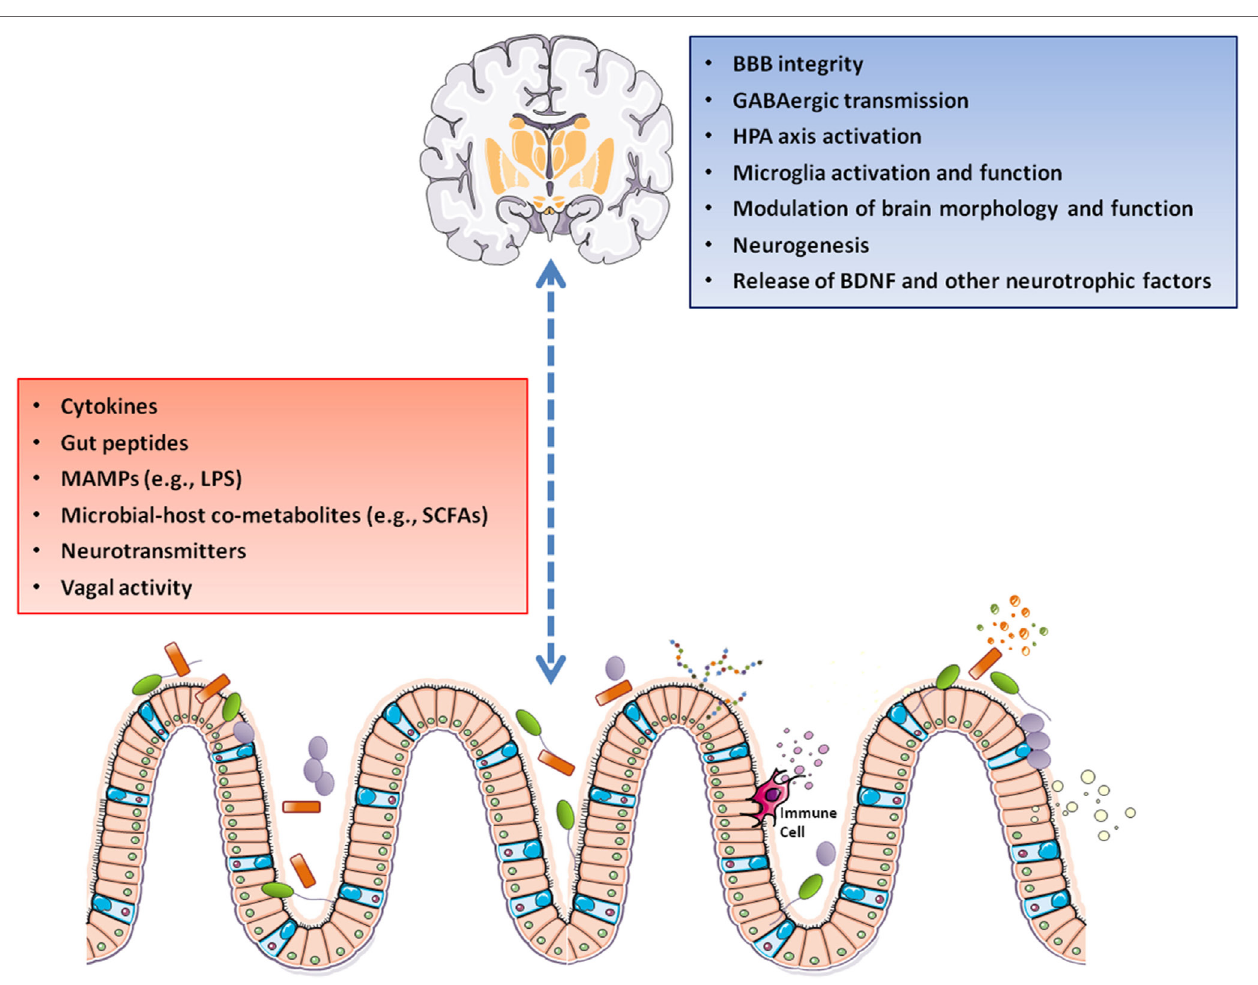
FiGURe 1 | A gut–brain axis supports the interactions between gut microbiota and the CNS through direct and indirect pathways involving vagal nerve activation, cytokine production, and release of neuropeptide/neurotransmitters and SCFAs. These mediators can pass the BBB and control the maturation and activation of brain immune cells (microglia). Following its activation, microglia modulates immune surveillance, synaptic pruning, and clearance of debris. On the other side, the HPA axis can suppress microglia activation, as well as influence cytokine release and trafficking of monocytes from the periphery to the brain. Abbreviations: BBB, blood–brain barrier; BDNF, brain-derived neurotrophic factor; GABA, gamma-aminobutyric acid; HPA axis, hypothalamic–pituitary–adrenal axis; LPS, lipopolysaccharide; MAMPs, microbe-associated molecular patterns; SCFAs, short-chain fatty acids; CNS, central nervous